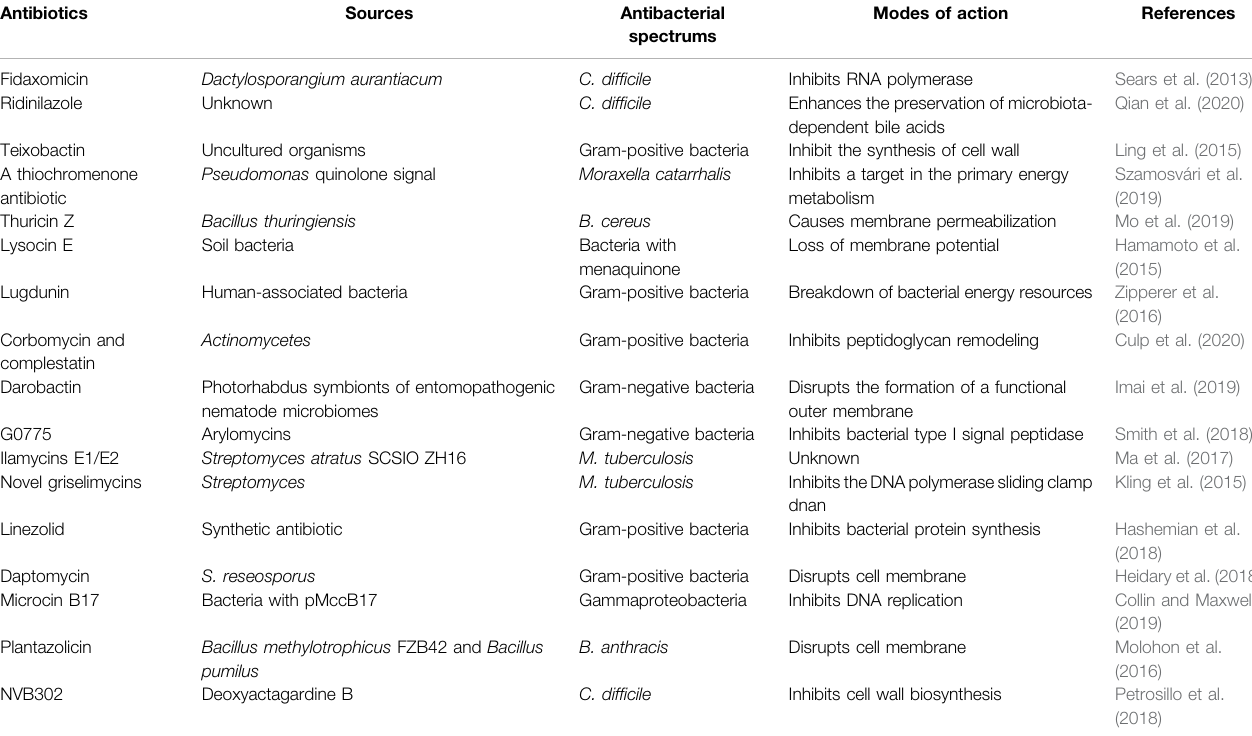
TABLE 1 | Sources, spectrums, and modes of action of representative narrow-spectrum